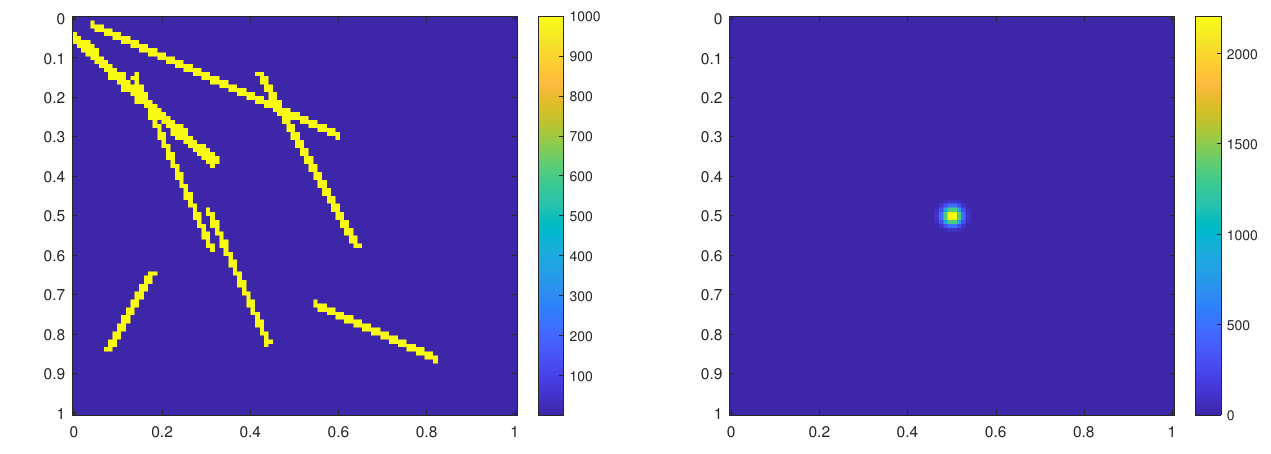
Figure 1. Left : Medium κ ; Right : Source function f .